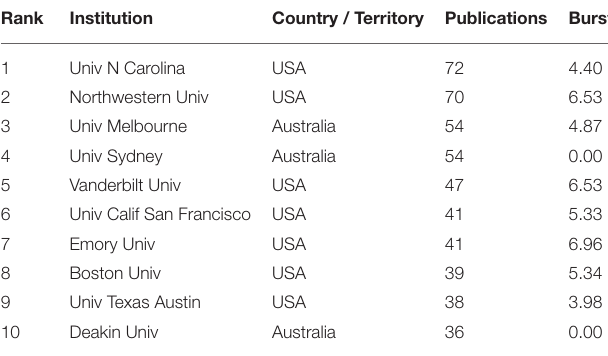
TABLE 3 | The top 10 institution in the field of health literacy